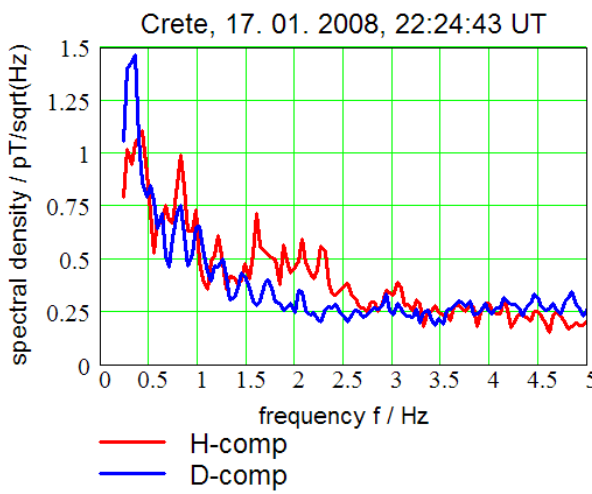
Fig. 5. Magnetic background noise amplitude spectra of CR as ob- served at the given date and time. The data were corrected for the frequency response of the instrument and calibrated. Eight individ- ual 512 point FFT realisations were averaged resulting in a time resolution of 410s. The time given refers to the centre of the 410s time period. The time average is large enough to suppress suffi- ciently instrumental noise and small enough to guarantee a quasi stationary situation ( ∼ 230 registered lightning flashes world-wide in the given time interval according to World Wide Lightning Loca- tion Network).